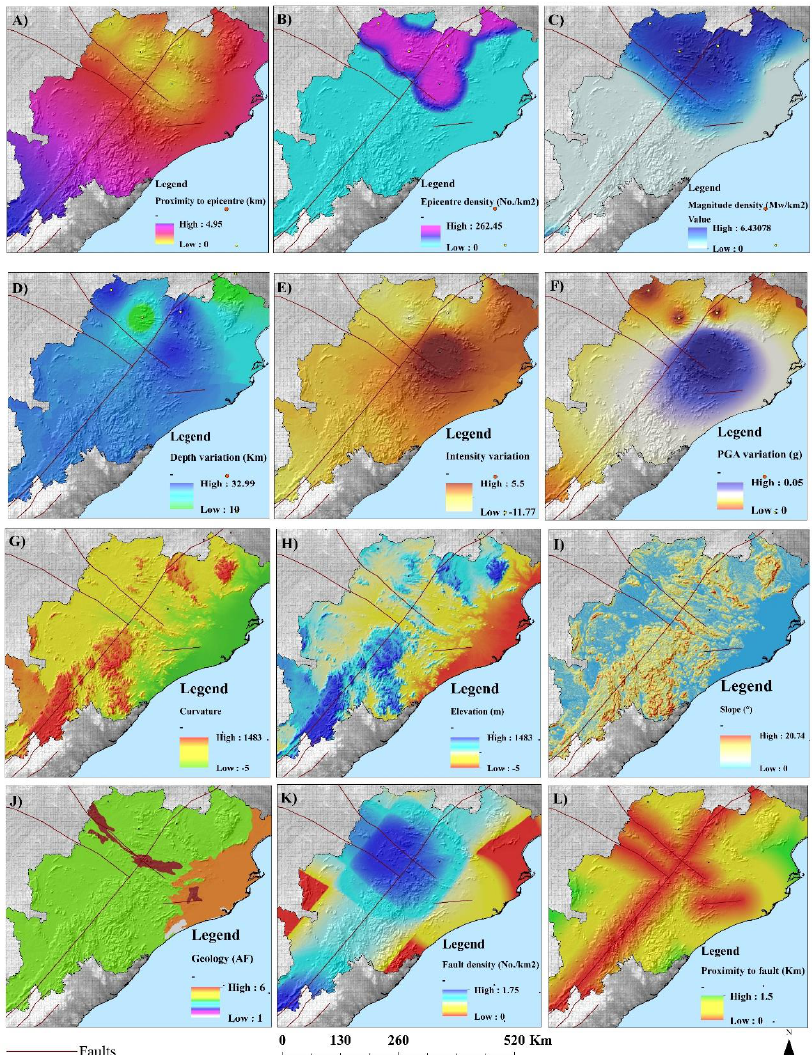
Figure 2. Several indicators used for susceptibility to seismic amplification (SSA) and probability assessment in this study. ( A ) Proximity to epicenter (km); ( B ) epicenter density(no./km 2 ); ( C ) magnitude density (Mw/km 2 ); ( D ) depth variation (km); ( E ) intensity variation; ( F ) peak ground acceleration (PGA) variation (g); ( G ) Curvature; ( H ) elevation (m); ( I ) slope (degree); ( J ) geology (amplification factor); ( K ) fault density (no/km 2 ); ( L ) proximity to fault (km).